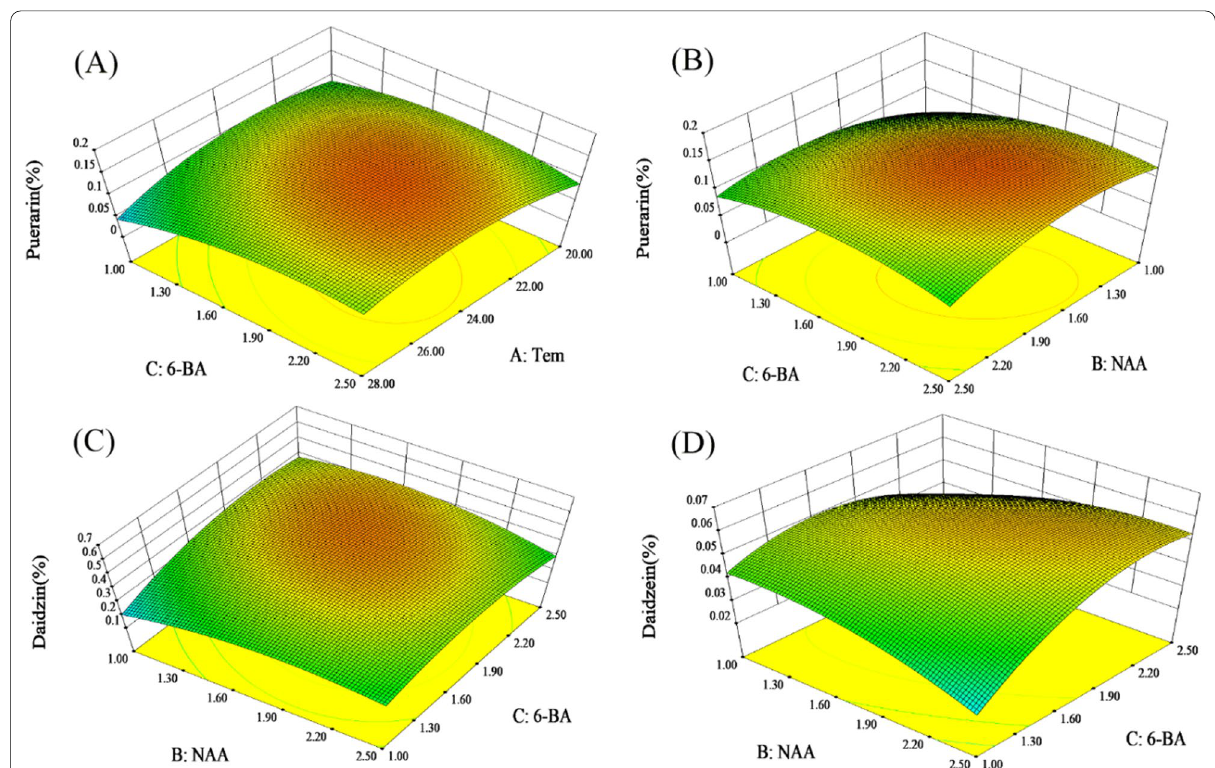
Fig. 4 Three-dimensional (3D) response surface plots showing the effects of variables (temperature, 6-BA and NAA) on puerarin, daidzin, and daidzein synthesis in P. thomsonii callus culture. A , B The model generated by the CCD on production of puerarin (%), C production of daidzin (%), D production of daidzein (%). The optimum temperature ranging from 20.0 to 28.0 °C, 6-BA and NAA concentrations between 1.00 and 2.50 mg/L, respectively. Color-coding indicates high (red) and low (green)